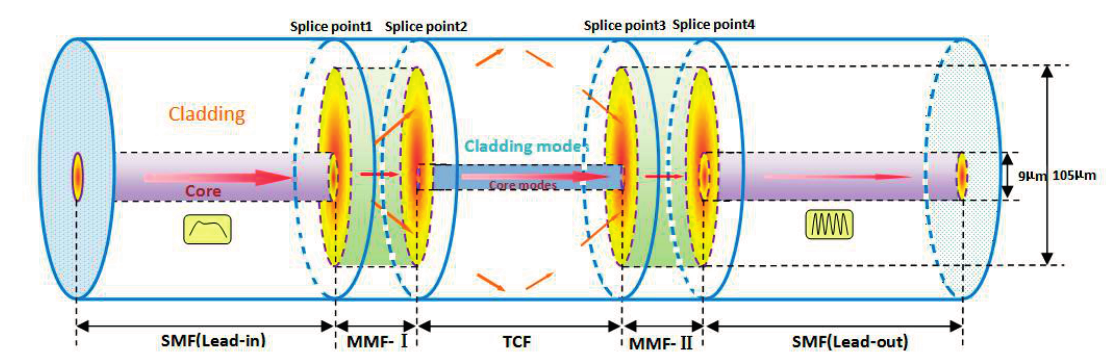
Figure 1. Schematic diagram of the MZI